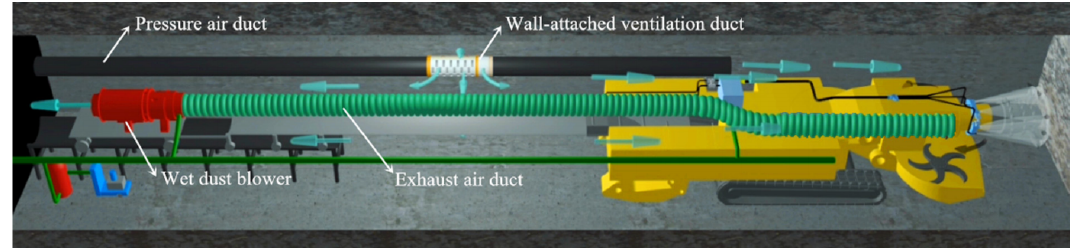
Figure 8. Diagram of the site assembly [59].